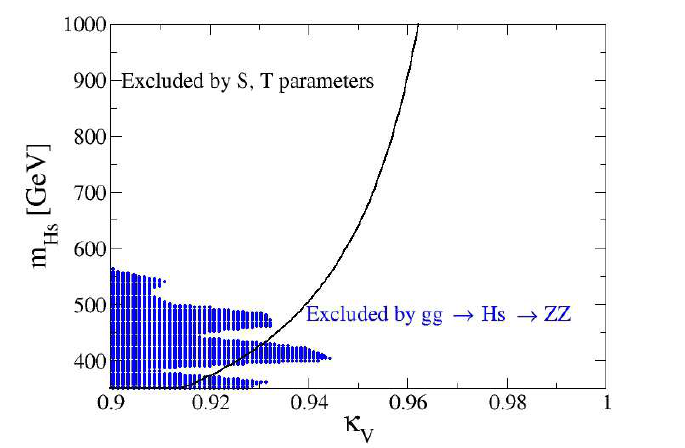
– m plane in the HSM. The blue shaded region is V H S H S ZZ process. The region above the black solid curve is → →